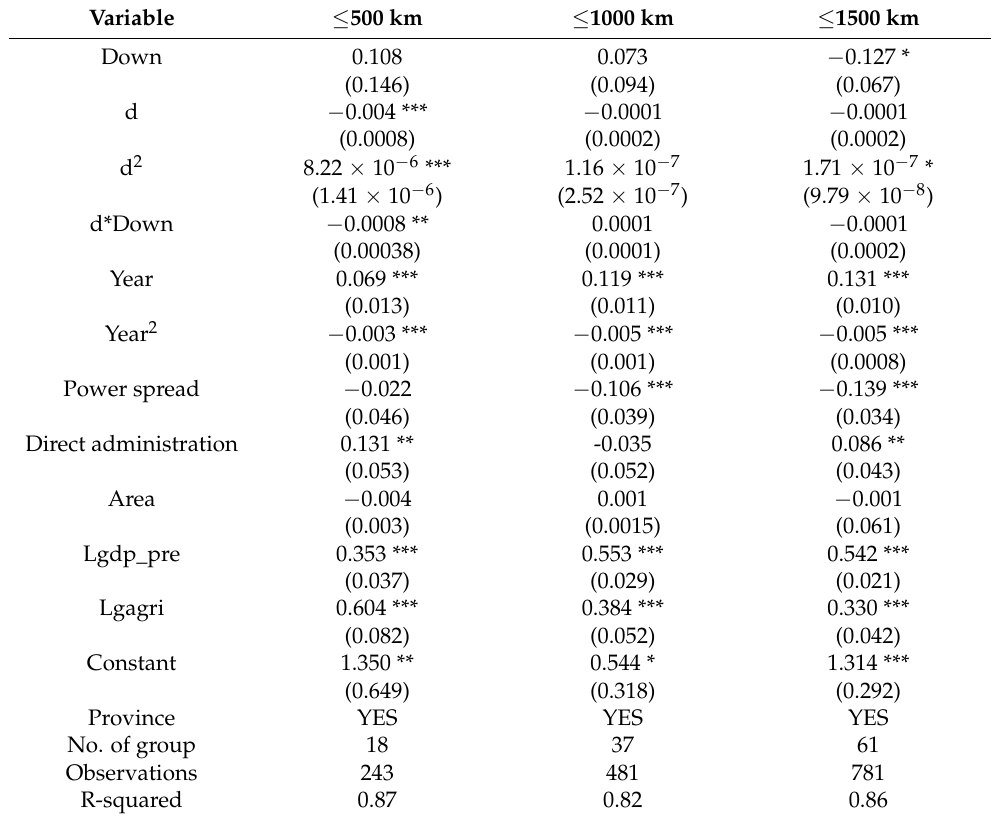
Table A2. The robust results—The economic impact of building the TGD by different groups of distance (The downstream regions).